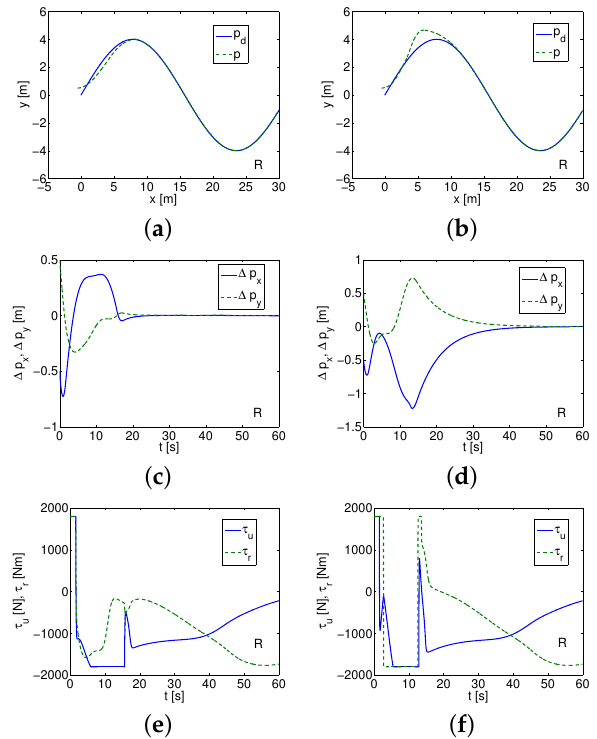
Figure 13. Simulation results for sine trajectory and ROPOS TSMC—left, and FTSMC—right. ( a , b ) Desired and realized trajectory; ( c , d ) position errors; ( e , f ) applied